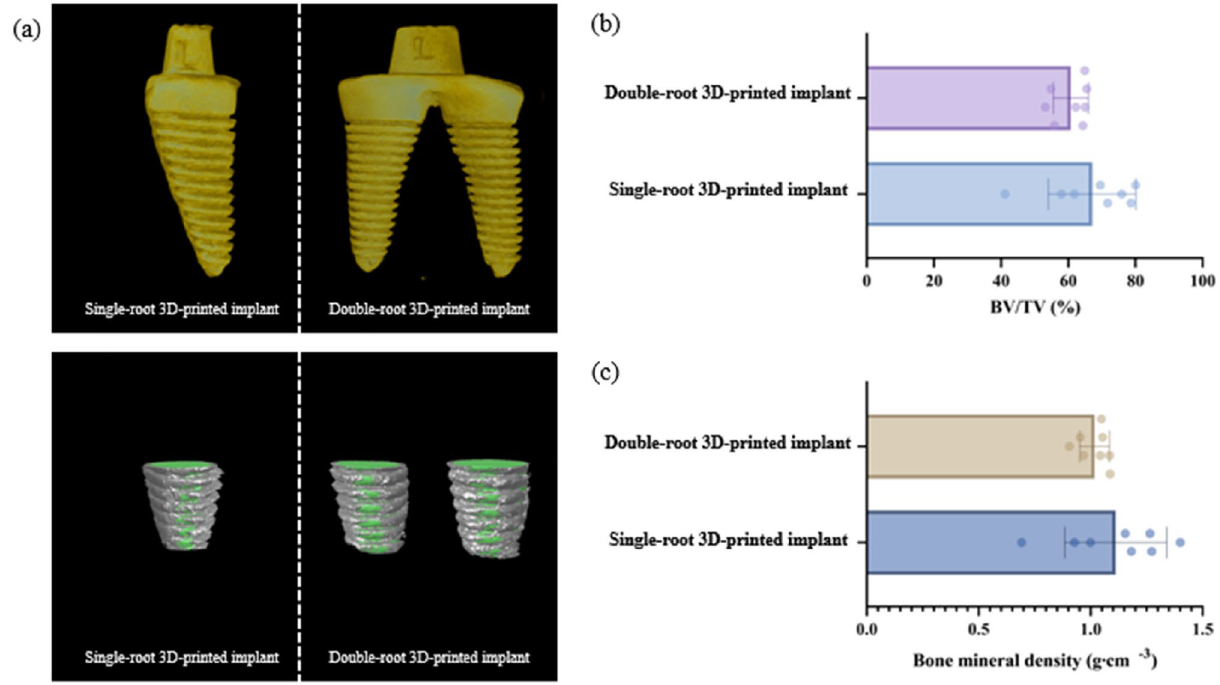
Figure 4. Representative micro-computed tomography ( a ) and analysis ( b , c ). ( a ) Gray and green areas indicate the VOI and 3D-printed implants, respectively. BMD and BV/TV were measured in the gray area. ( b ) The BV/TV of single-root and multi-root 3D printed implant were 67.11 ± 13.05% and 60.76 ± 5.43%, respectively, showing no statistically significant difference. ( c ) The bone mineral density of single-root and multi-root 3D printed implant were 1.11 ± 0.23 g mm −3 and 1.02 ± 0.08 g mm −3 , respectively, showing no statistically significant difference. CT: computed tomography, VOI: volume of interest, 3D: 3-dimensional, BMD: bone mineral density, BV/TV: bone volume/tissue